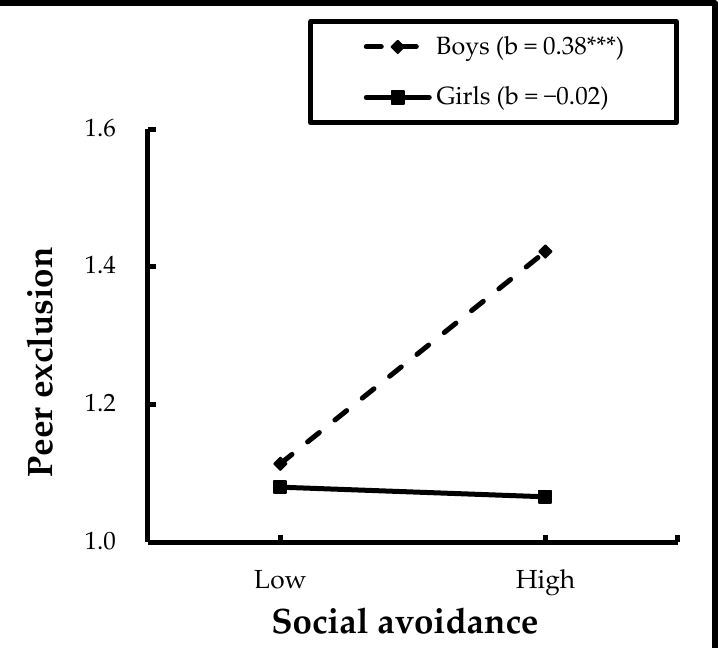
Figure 3. Interactions between social avoidance and gender in predicting peer exclusion. *** p < 0.001.